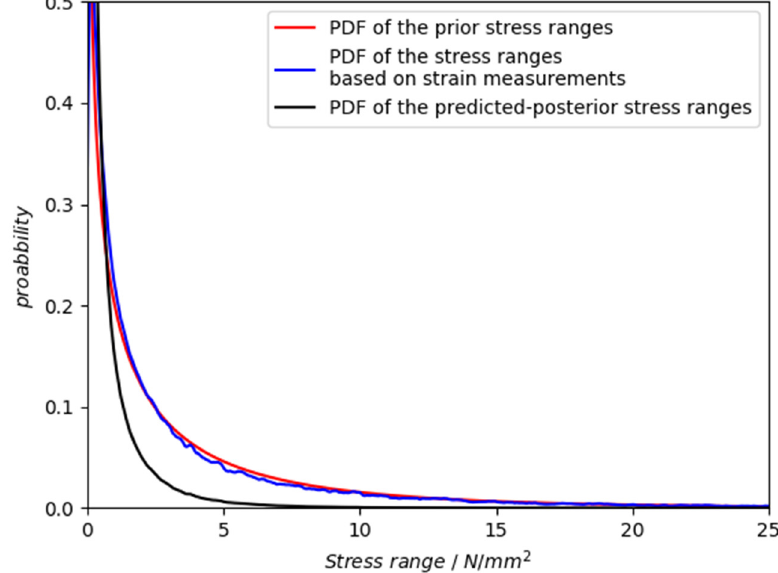
Figure 10. Graphical representation of the probability density function of the predicted posterior stress range, 𝑓(cid:3435)Δ𝜎 (cid:3005)(cid:3032)(cid:3046)(cid:3036)(cid:3034)(cid:3041) |Δ𝜎 (cid:3014) (cid:3439) , (black curve), together with the PDFs of the prior stress range, 𝑓(Δ𝜎 (cid:3005)(cid:3032)(cid:3046)(cid:3036)(cid:3034)(cid:3041) ) , and the stress ranges based on strain measurements, 𝑓(cid:3435)Δ𝜎 (cid:3014) (cid:3627)Δ𝜎 (cid:3005)(cid:3032)(cid:3046)(cid:3036)(cid:3034)(cid:3041) (cid:3439) , at position 2 for a northerly wind direction.